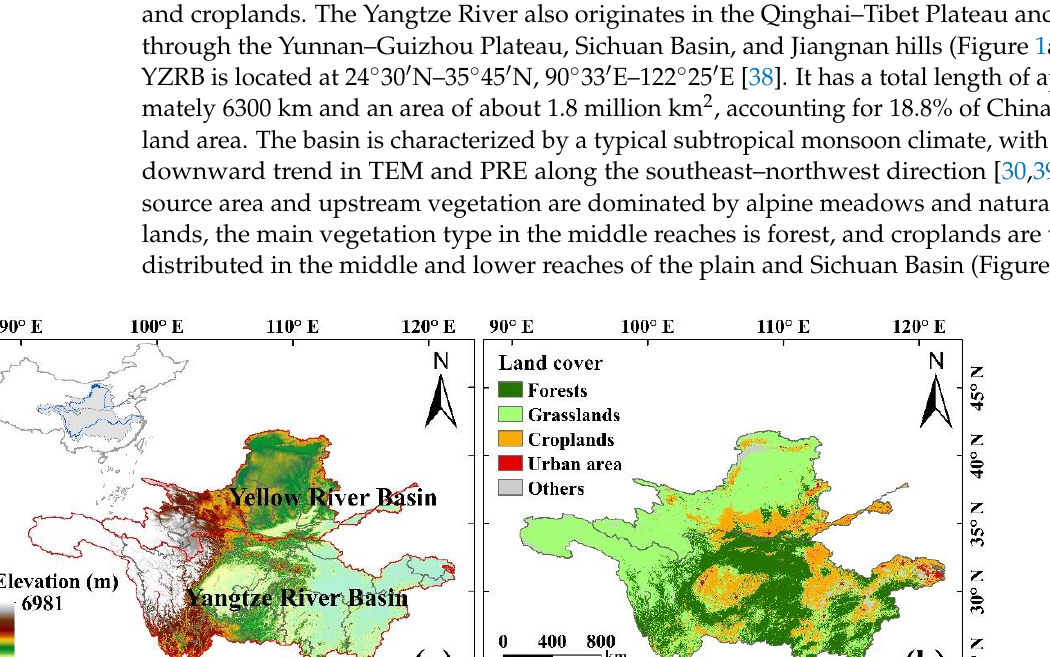
Table 1. Drought severity classification of SEDI values [12] .